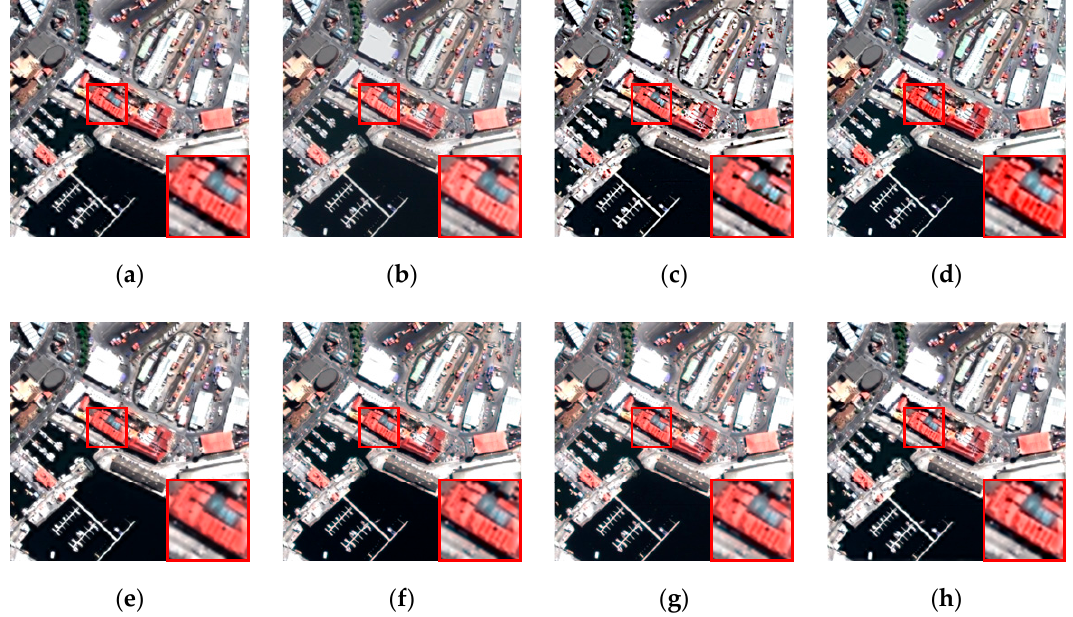
Figure 9. Fusion results of real data set from the GeoEye-1 satellite: ( a ) ATWT; ( b ) GS; ( c ) MTF-GLP-CBD; ( d ) BDSD; ( e ) MF-HG; ( f ) GSA-BPT; ( g ) GSA-HA; and ( h ) proposed method.